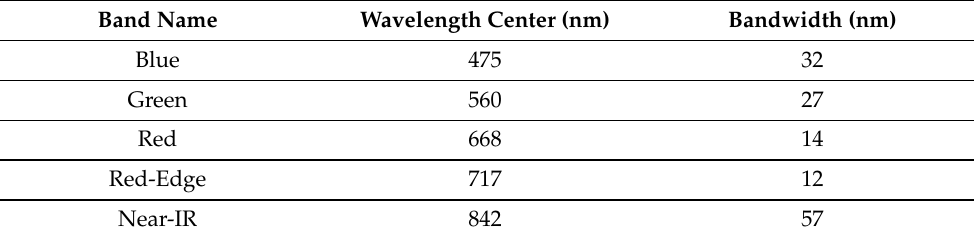
Table 1. Multispectral specifications of the sensor.